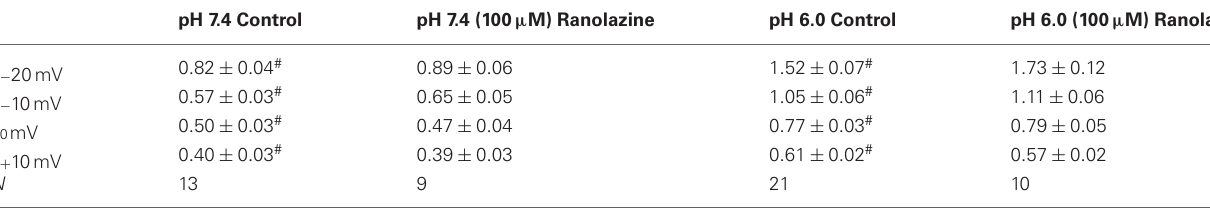
Table A2 | Time constants of fast inactivation.